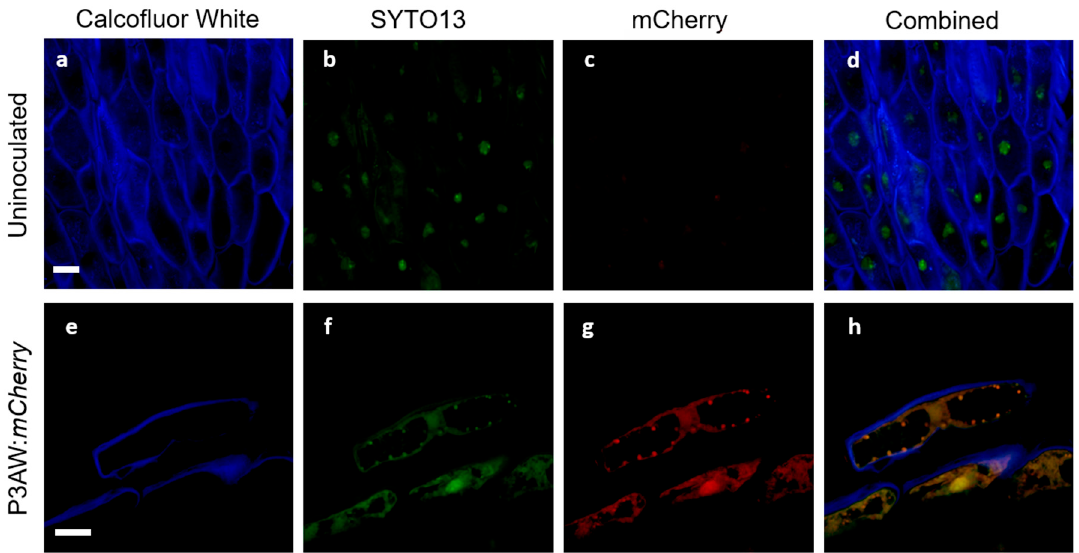
Figure 11. Validation of confocal microscopy as a method to track P3AW: mCherry in clover cells. ( a – d ) Sloughed-off root cells of uninoculated plants. ( e – g ) Sloughed-off root cells of P3AW:mCherry- inoculated plants. ( a , e ) Fluorescence of Calcofluor-White-stained cell walls using the 405 nm laser. ( b , f ) Fluorescence SYTO-13-stained DNA using the 488 nm laser. ( c , g ) Fluorescence of mCherry using the 594 nm laser. ( d , h ) Combined fluorescence images using all three lasers. No fluorescence was detected in either ( b ) or ( c ). Scale bar = 10 μ m.